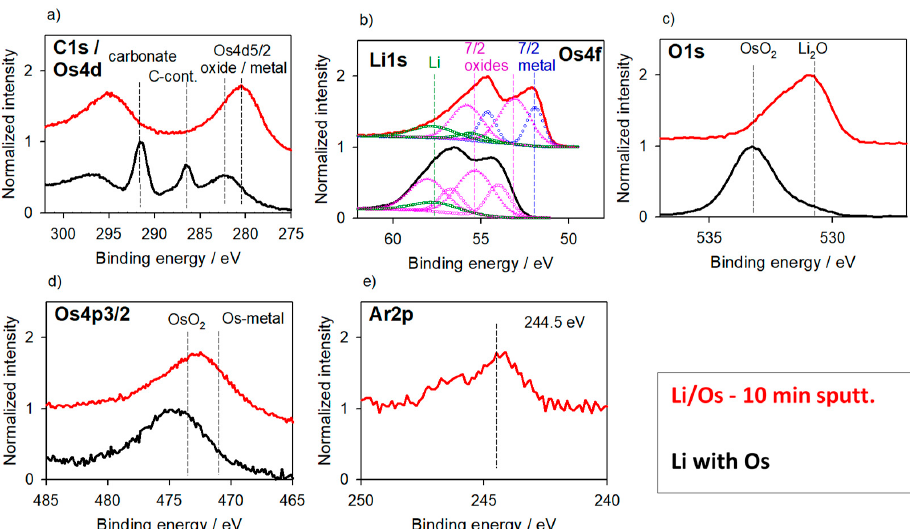
Figure 3. XP spectra normalized in intensity of a Li foil treated with OsO 4 vapor before and after 10 min sputter cleaning ( bottom to top ). No charging; no charge compensation. Interpretation is disturbed because C1s and Li1s peaks are overlaid with Os4d and Os4f, resp. Osmium is found as an oxide at the surface and mainly as metal after sputtering (see fit in Figure 3b). All characteristic peaks are shifted by around 2 eV to higher BE; Ar2p is also at high BE of 244.5 eV. ( a ) C1s/Os4d; ( b ) Li1s; ( c ) O1s; ( d ) Os4p 3/2 ; ( e ) Ar2p transition.